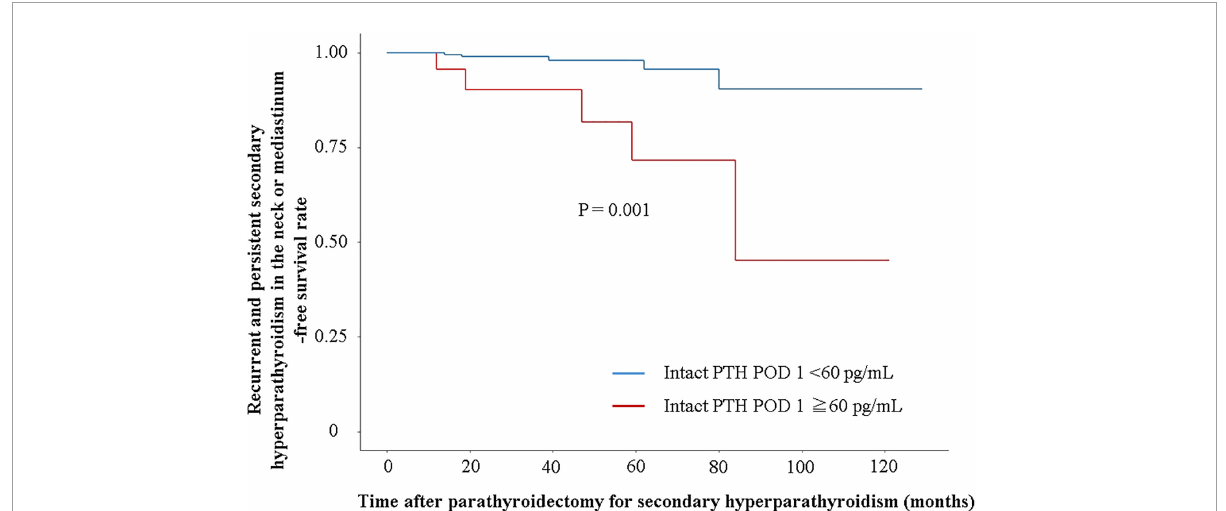
FIGURE2 Recurrent and persistent secondary hyperparathyroidism-free survival rate in the neck or mediastinum. Recurrent and persistent secondary hyperparathyroidism-free survival rate is evaluated using Cox regression analysis adjusted with inverse probability of treatment weighting by sex, age, body mass index, dialysis vintage, and intact PTH levels at